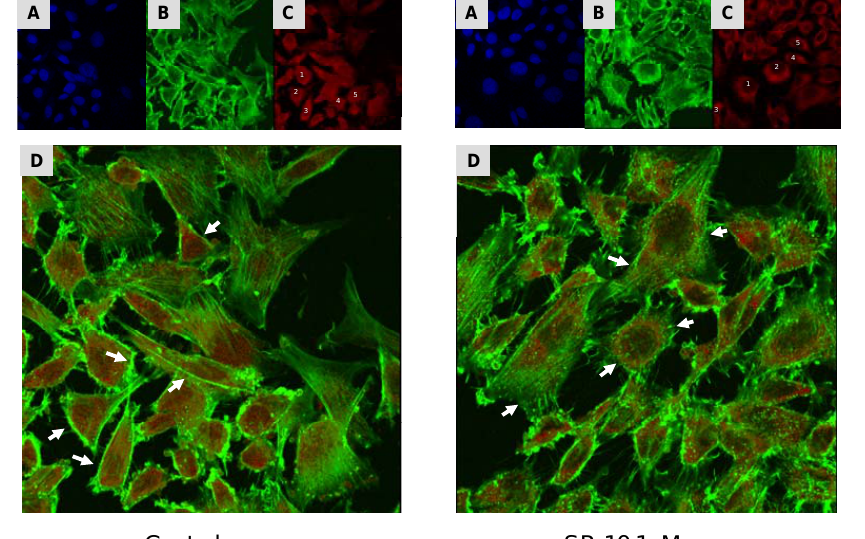
Figure 9. Effect of SP-10 on actin localization. Y-1 cells grown on coverslips were treated with SP-10 for 48 h, then washed with PBS and fixed in 4% paraformaldehyde. The cell membranes were permeabilized with 0.1% Triton X-100, then stained with Alexa Fluor 488 phalloidin for F-actin (Green) and Alexa Fluor 594 Deoxyribonuclease I (red) for G- actin. Nuclear DAPI staining (blue; A), F-actin (B) and G-actin (C) localization in control and SP-10 treated cells are shown in the top panels. Panel D shows merged images of F- and G- actin localization. Arrows indicate changes in F-actin distribution. Cells numbered from 1 to 5 on panel C were used for F-actin and G-actin fluorescence quantification.